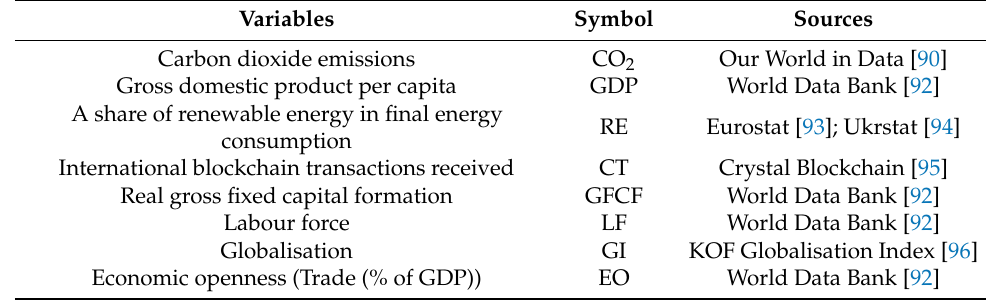
Table 1 contains the description of variables and sources. Table 1. The variables of the research and